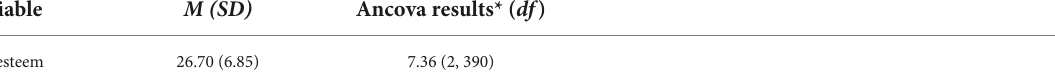
TABLE 3 Results of analysis of covariance for resilience, stigma exposure, self-esteem, and depression. Variable